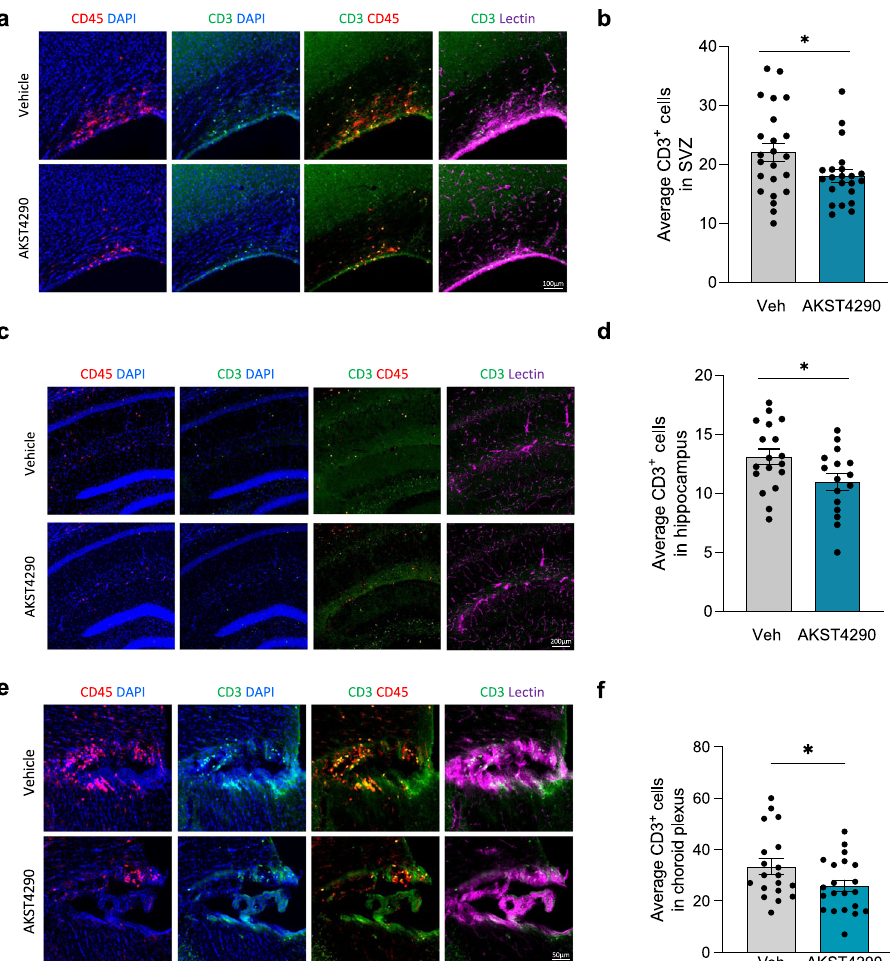
Fig. 3 T-cell in fi ltration in the aged mouse brain is reduced by CCR3 inhibition. 24-month-old male mice were treated with vehicle or AKST4290 for 5 weeks. a Representative images of CD3 T cells co-stained with CD45 and vessel marker Lectin in the subventricular zone (SVZ). b Average number of CD3 + T cells in the SVZ (* p < 0.05, unpaired t- test; n = 23, 22). c Representative images of CD3 + T cells co-stained with CD45 + macrophages and vessel marker Lectin in the hippocampus. d Average number of CD3 + T cells in the hippocampus (* p < 0.05, unpaired t- test; n = 18, 16). e Representative images of CD3 + T cells co-stained with CD45 + macrophages and vessel marker Lectin in the choroid plexus of the third ventricle. f Average number of CD3 + T cells in the choroid plexus (* p < 0.05, unpaired t -test; n = 21, 20). All data shown are mean ± standard error of the